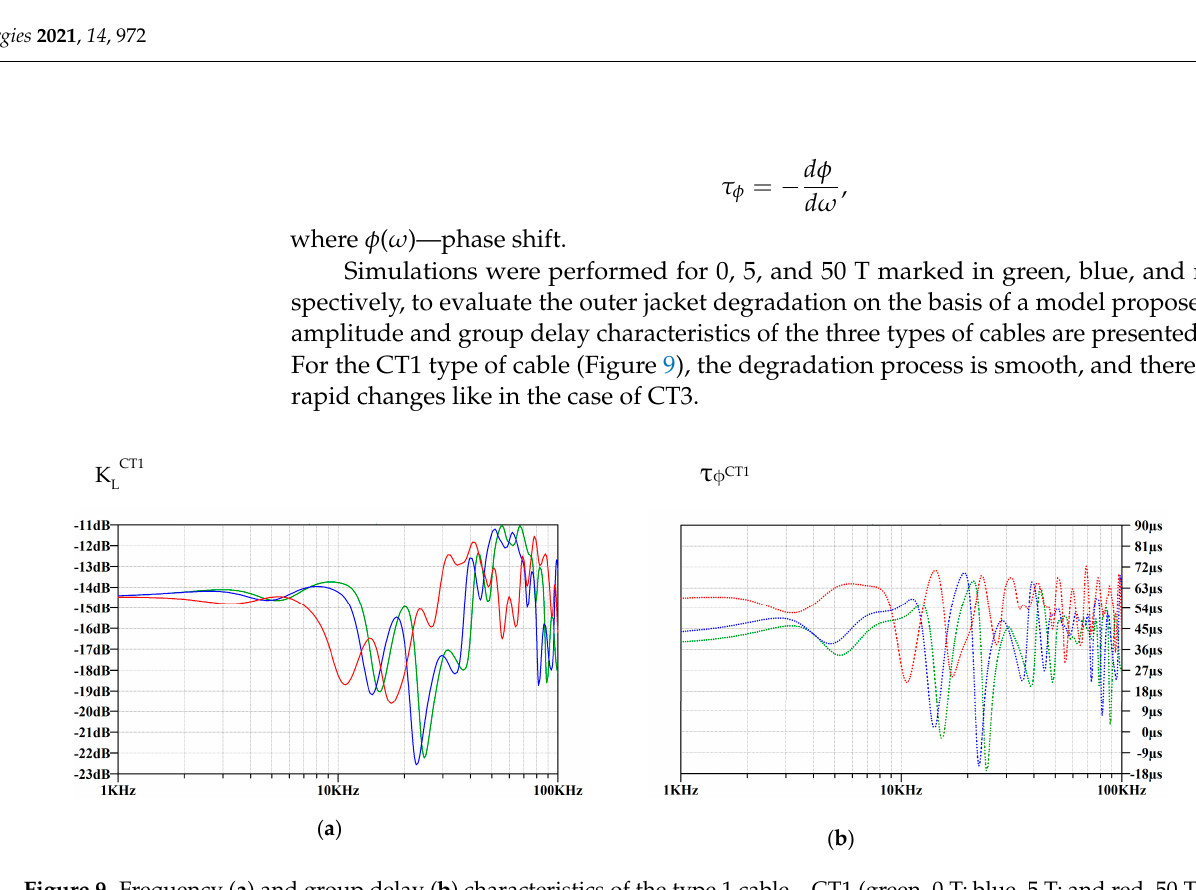
Figure 9. Frequency ( a ) and group delay ( b ) characteristics of the type 1 cable—CT1 (green, 0 T; blue, 5 T; and red, 50 T).